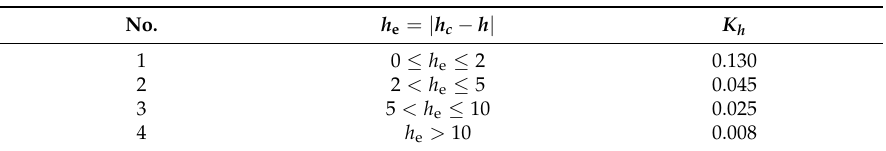
Figure 9. The block diagram of the proposed OECS. OECS, optimal energy control system; LQG, linear-quadratic-Gaussian. Table 3. The gains used in the gain